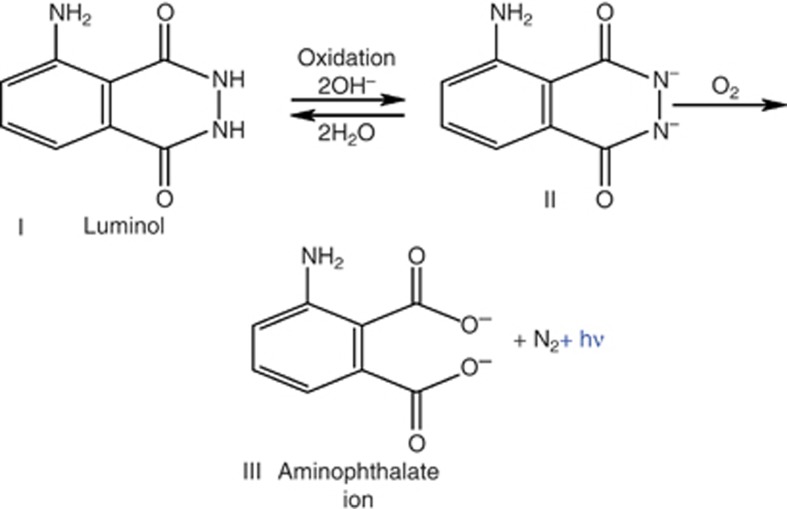
The chemiluminescence reaction of luminol C8H7N3O2 (I) in relatively nonacidic solvents, resulting in aminophthalate ion (III), which is a light-emitting species2.